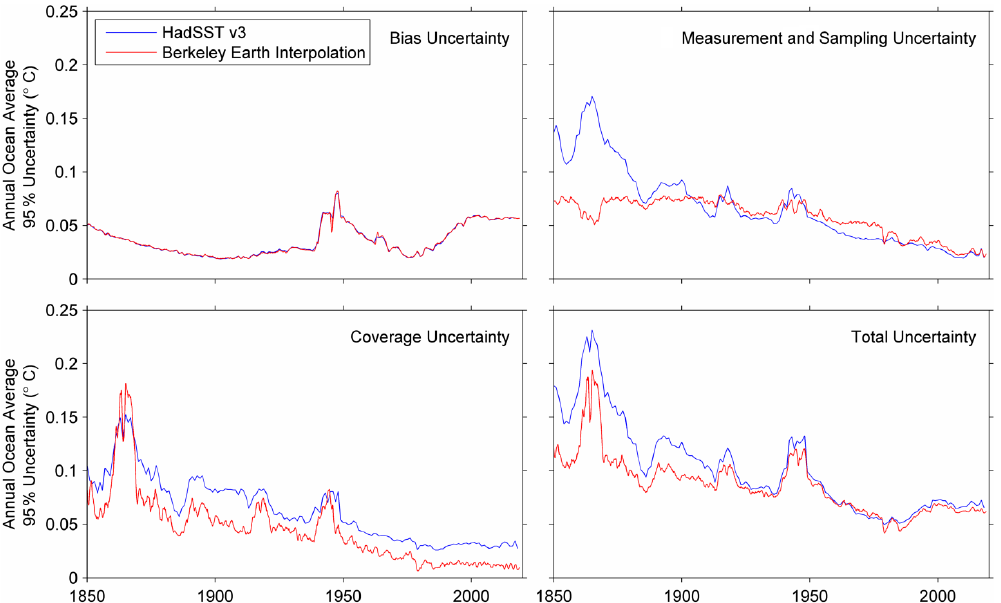
Figure 2. Component uncertainties for the ocean average of HadSST v3 and the corresponding transformed forms of those components after the application of the interpolation scheme described in the text. All uncertainties are expressed as appropriate for 95% confidence intervals on annual ocean